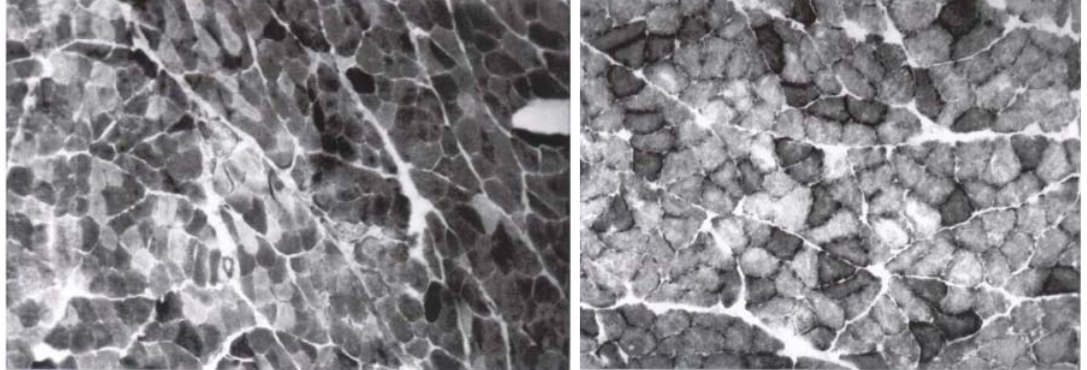
Figure 4a. PAS stain, plantaris muscle, 30-month old underfed Figure 4b . NADH stain, plantaris muscle, 30-month old